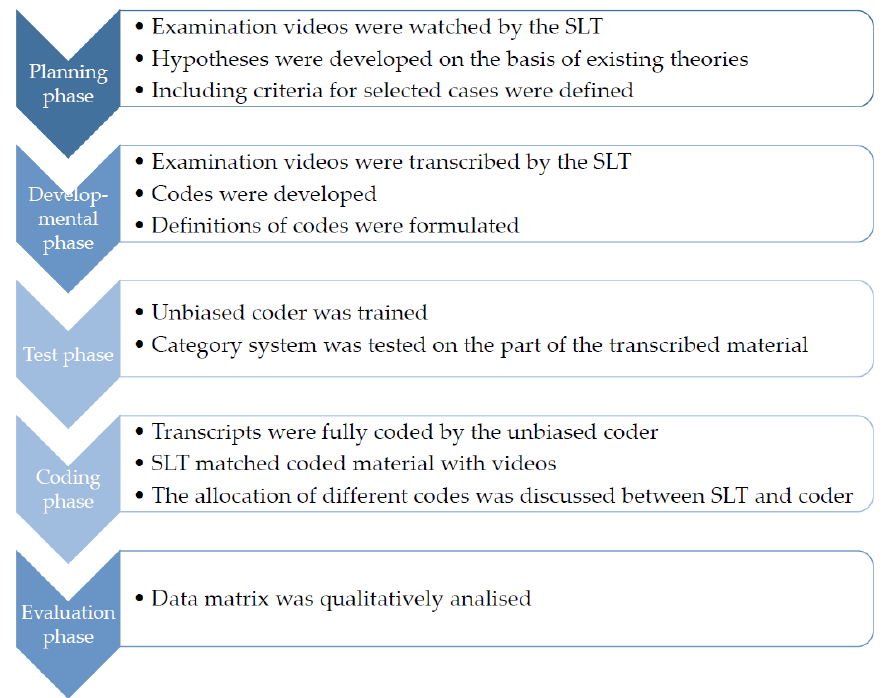
Figure 2. Process of qualitative content analysis according to Kuckartz (2018)